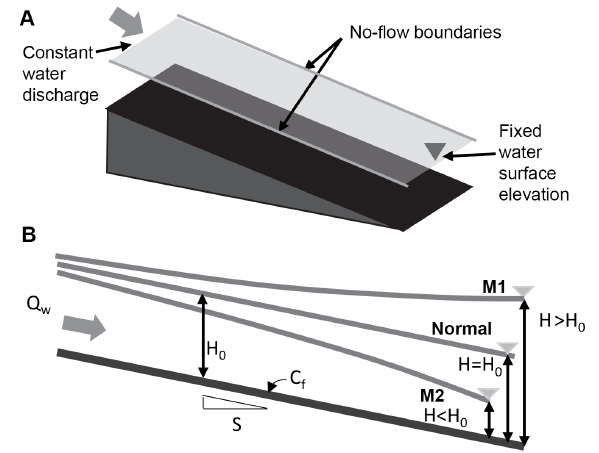
Figure 2. The setup of test 1 (straight channel test). (a) The channel has a rectangular cross section, constant bed slope and friction co- efficient. A constant discharge is fed into the upstream inlet. A fixed water surface elevation boundary condition is assigned at the down- stream outlet. (b) Three backwater profiles (M1, normal, and M2) are shown in the bottom diagram where downstream water surface elevation is respectively above, equal to, or below that of normal